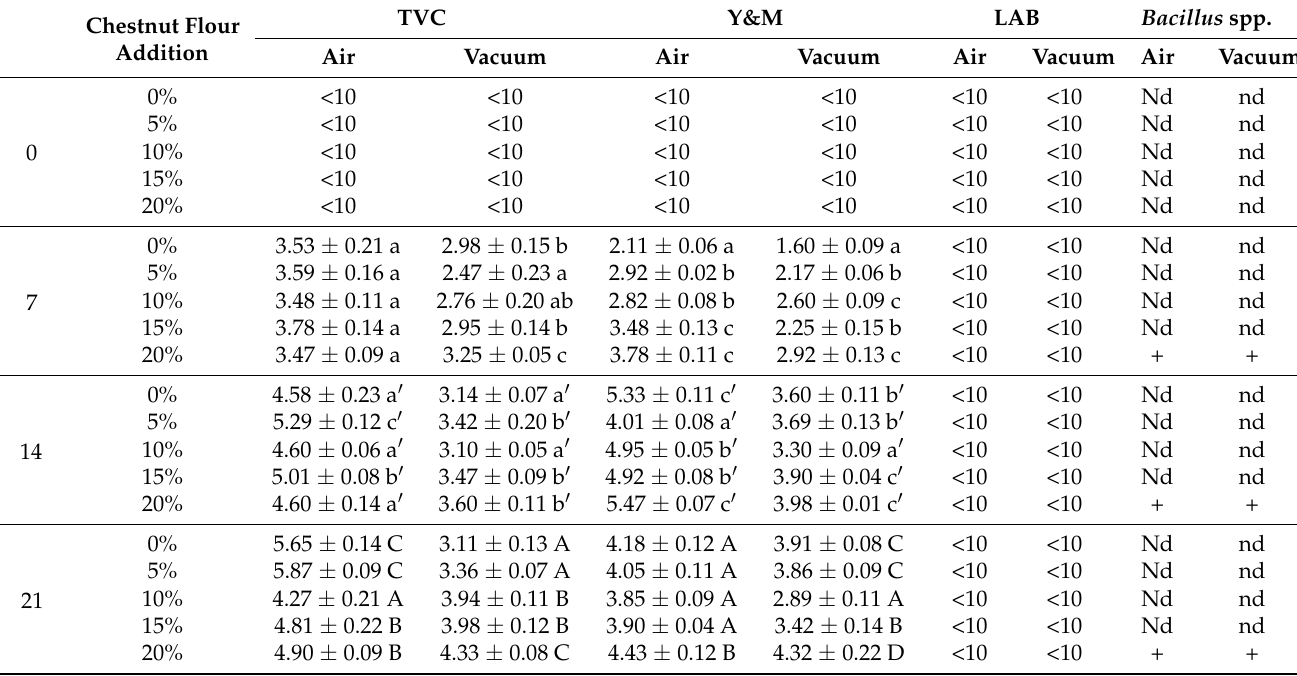
Table 5. TVC, Y&M, LAB and Bacillus spp. of gluten-free bread with the addition of chestnut flour in the amount of 0, 5, 10, 15 and